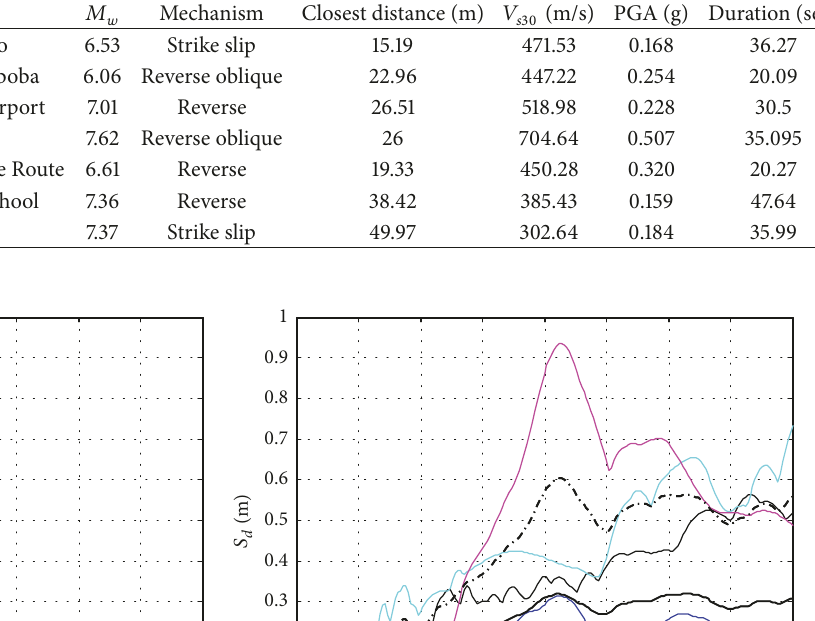
Table 5: Earthquake records used in dynamic time-history analysis.